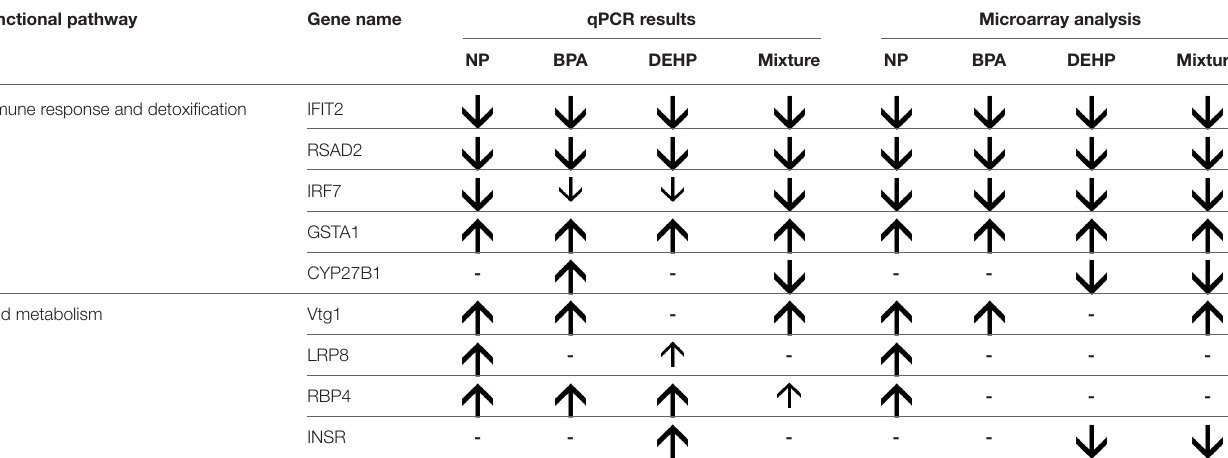
TABLE 5 | Comparison of microarray analysis and qPCR results.